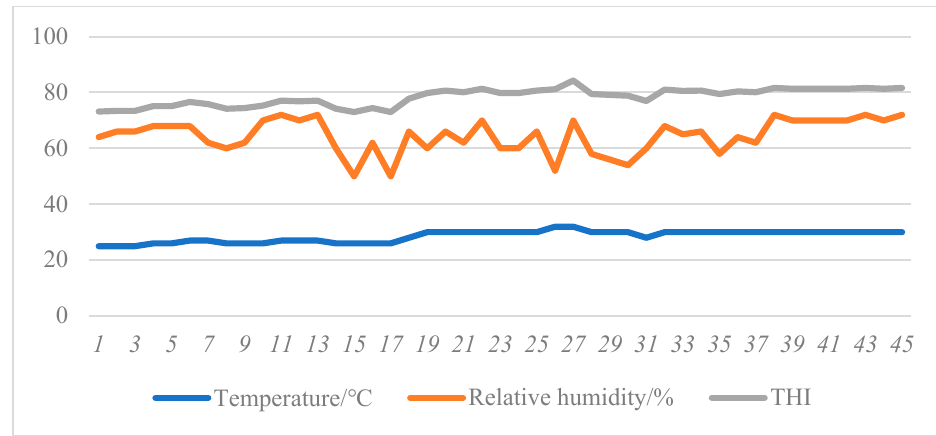
Figure 1. Temperature and humidity in the piggery during the experimental period.